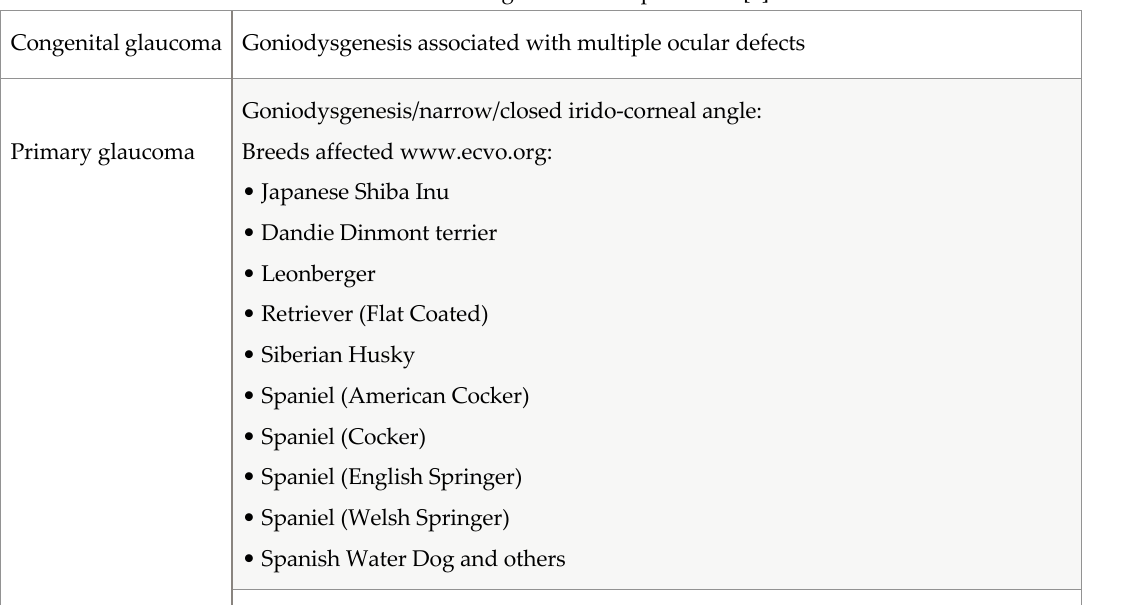
Table 1. Causes of glaucoma adapted after